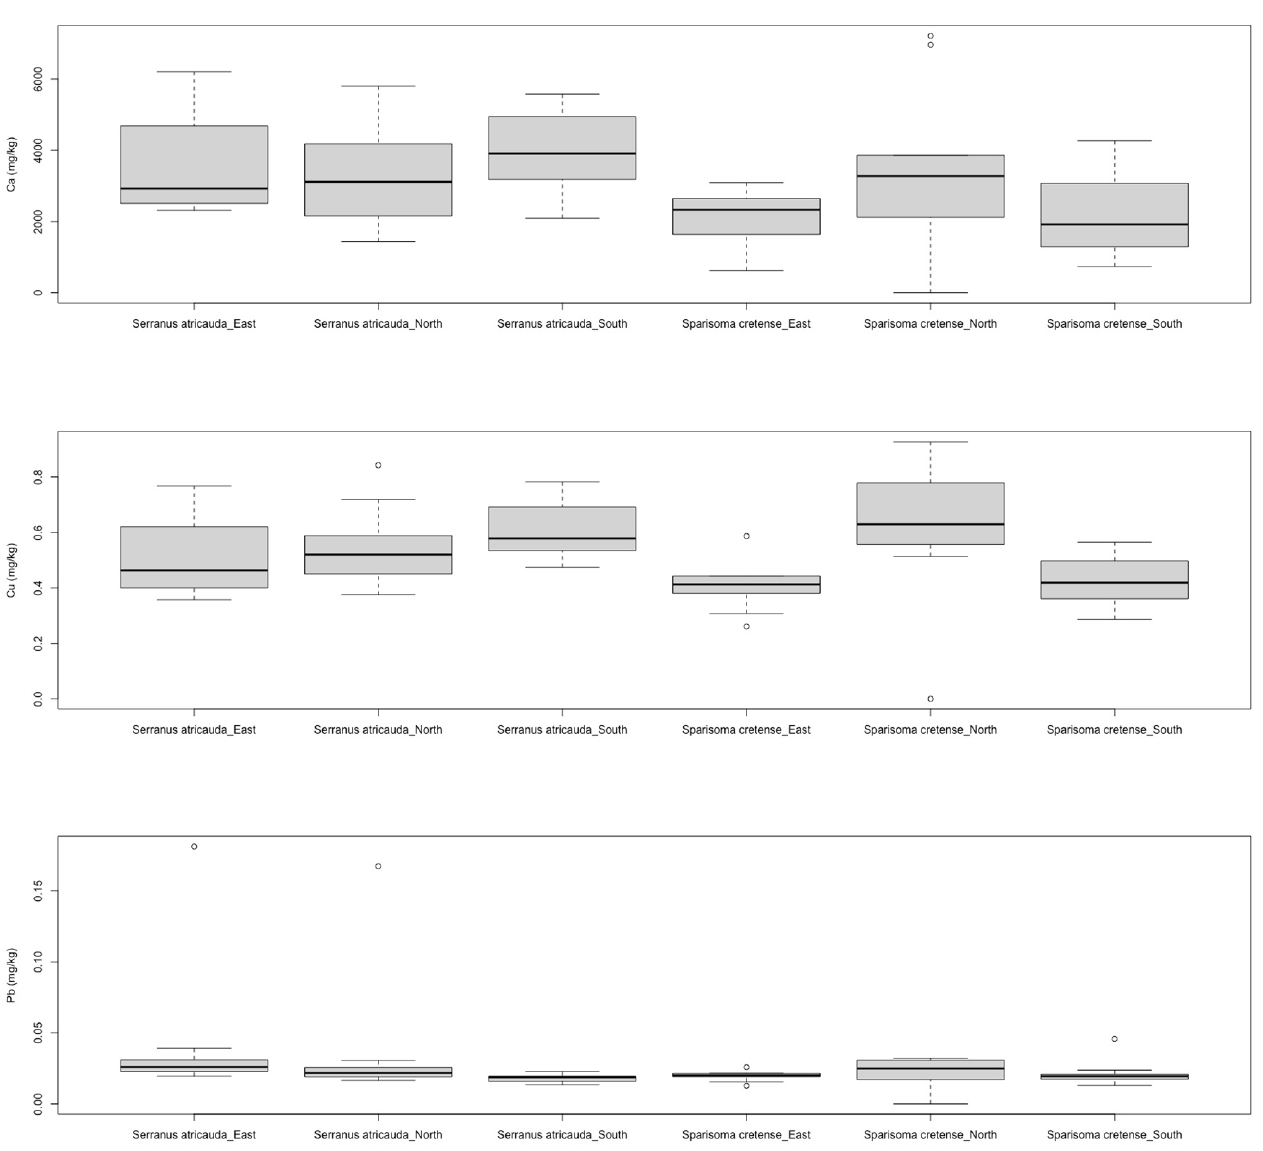
Figure 2. Boxplot of the two species in each sampling area for Ca, Cu and Pb.